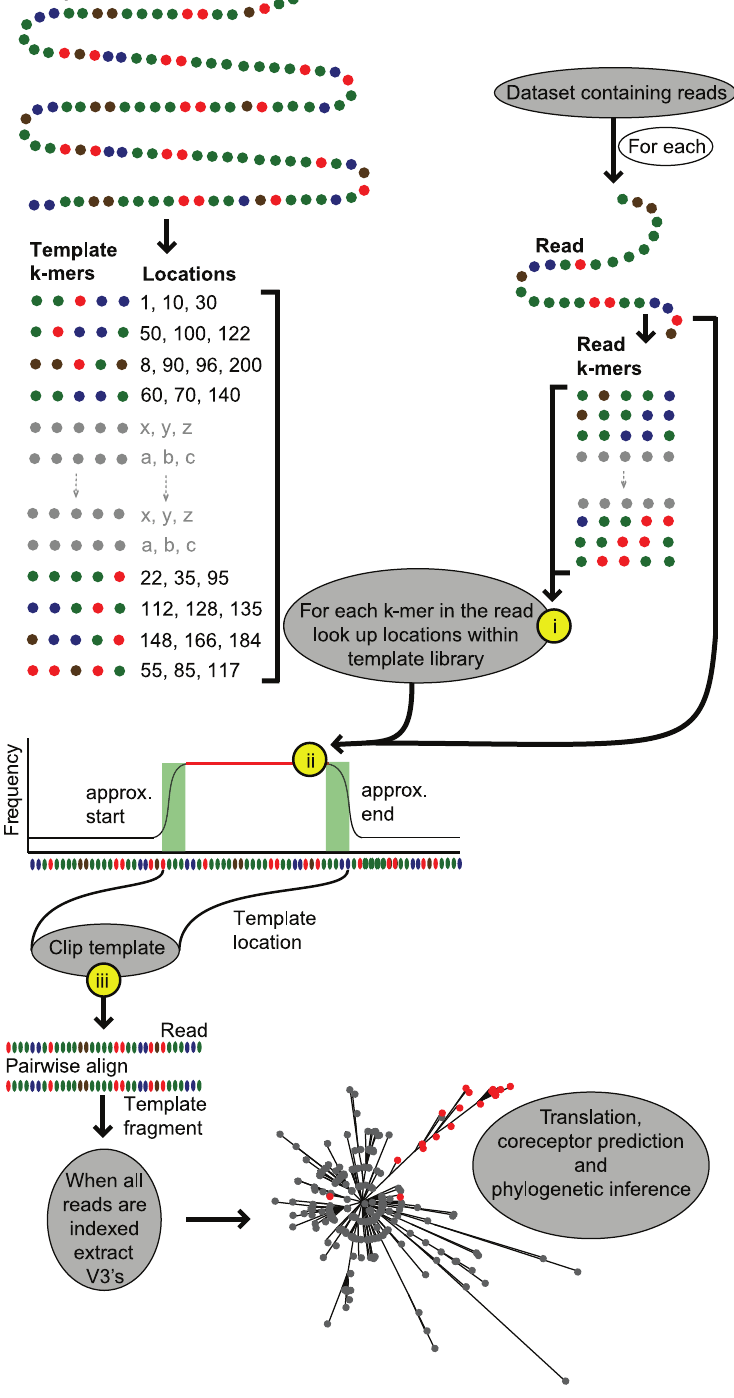
Figure 1. The data analysis framework. On the left hand side the preprocessing of the template sequence prior to read mapping is illustrated. The fragments titled ‘‘k-mers’’ are all the unique words (length=5) within the template sequence. These are stored along with their corresponding locations. On the opposite side all k-mers of equal length, extracted from the read, are shown. The plot indicates the frequency of k-mer matches across the template sequence for a single read. Grey boxes indicate processing events that take place within the framework. The yellow circles indicate optimization steps: (i) only exact k-mer matches used (ii) a heuristic alignment not constructed from the k-mer matching (just the k-mer match frequencies are plotted) and (iii) only the appropriate region of the template is pairwise aligned to the read.